Question: What does this figure show? Answer in one sentence.
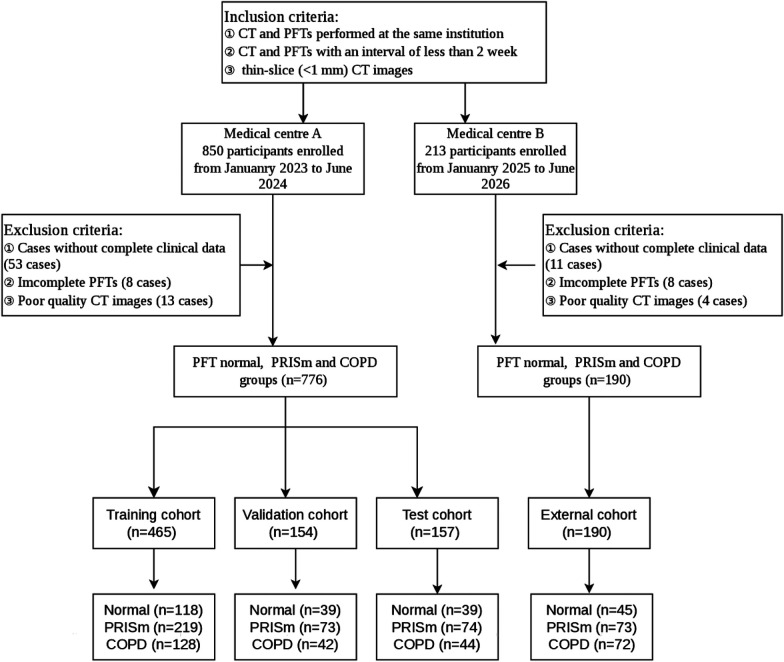
Answer: Participants recruitment process, inclusion and exclusion decision tree. PRISm, preserved ratio impaired spirometry; COPD, chronic obstructive pulmonary disease.